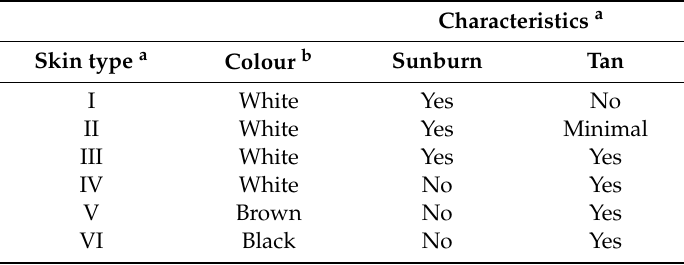
Table 1. Characteristics of the di ff erent types of skin according to the Fitzpatrick–Pathak